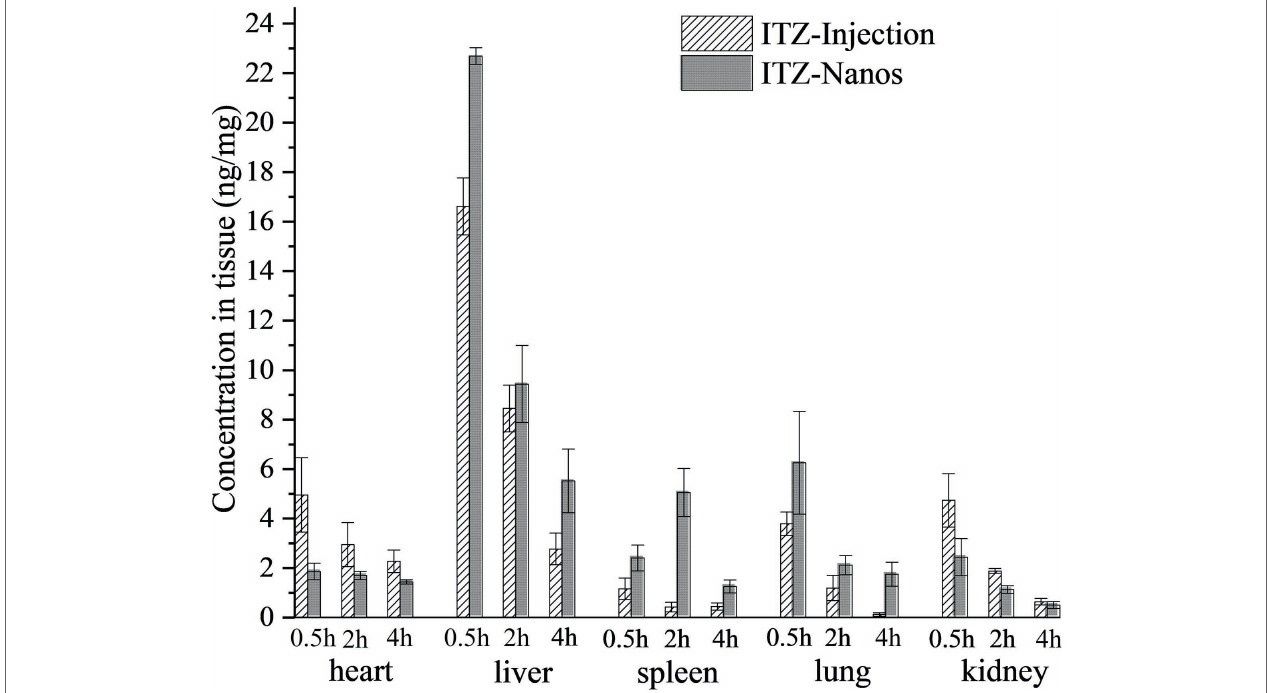
FIGURE 5 | Tissues distribution of ITZ after I.V. administration of two formulations in mice ( n = 5) at 0.25 h, 2 h, and 4